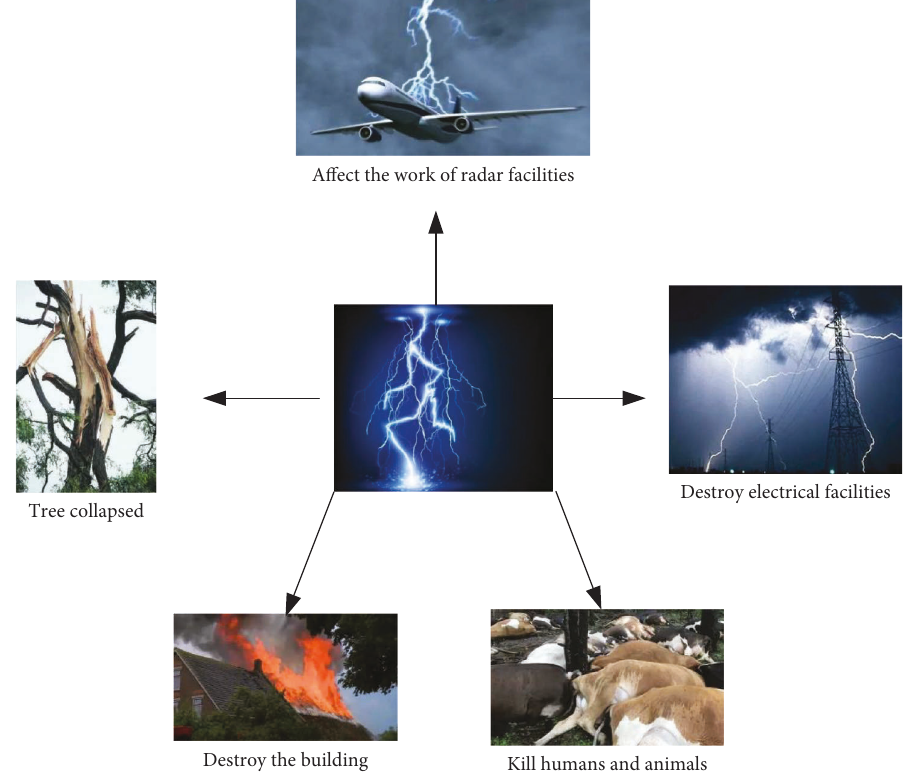
Figure 3: Harm from